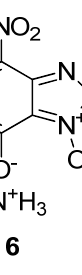
Figure 3. The structure of the salt formed as a by-product.